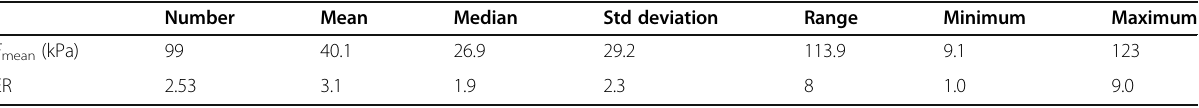
Table 2 Showing analysis of the elasticity indices of SWE Number